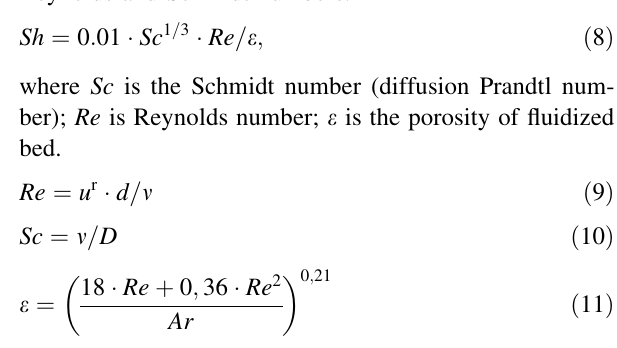
Table 8 Technical analysis of the desulphurized coal OLV (m/s) Moisture content ( W a ) (wt%)